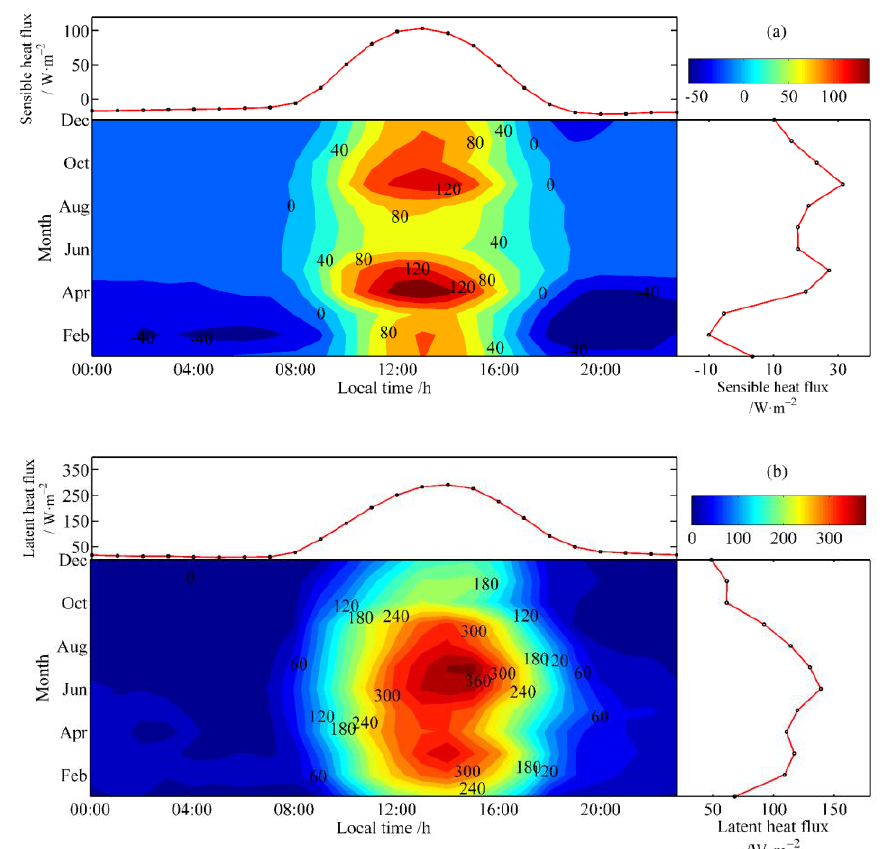
Figure 7. Annual mean diurnal variation ( top ), month-hour cross-sections ( bottom ) and monthly variation ( right ) of sensible heat flux ( a ), latent heat flux ( b ) in Dali from 2008 to 2009 (adapted from [59]).